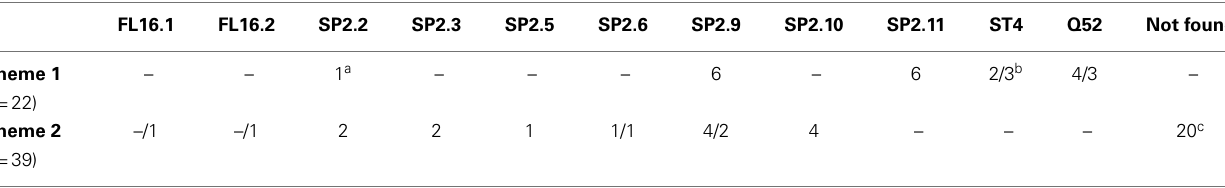
Table 1 | D H segment usage of IGVH171-encoded monoclonal anti-2-phenyloxazolone antibodies from BALB/c wild-type mice immunized with two different immunization schemes